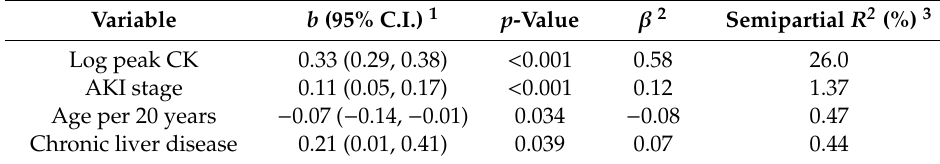
Table 5. Multivariable linear regression model for log ALT ( n =